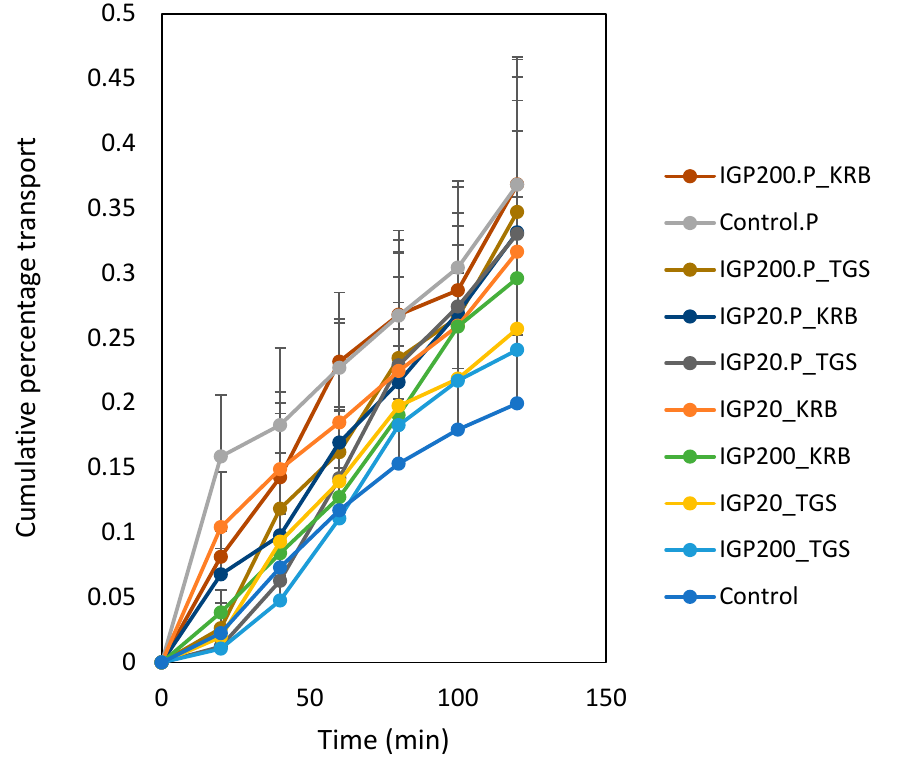
Figure 9. Apical-to-basolateral cumulative permeation of FD-4 alone (control) and from small microparticles (IGP20) and large microparticles (IGP200) with and without piperine (P) in Krebs- Ringer bicarbonate buffer (KRB) and the thermosensitive gel system (TGS) across excised ovine nasal tissue. Data are expressed as the mean cumulative percentage permeation ± standard deviation; n = 6.